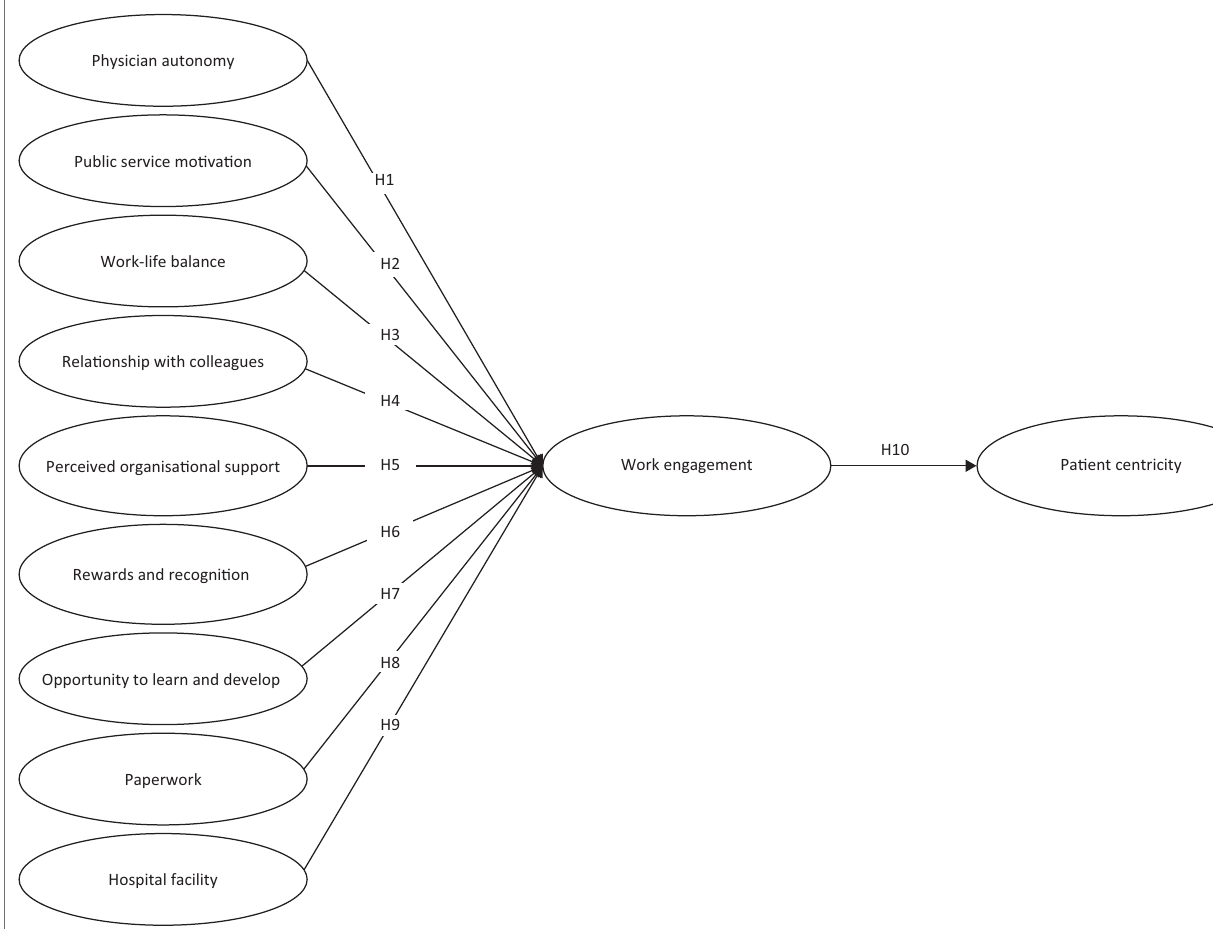
FIGURE 1: Conceptual